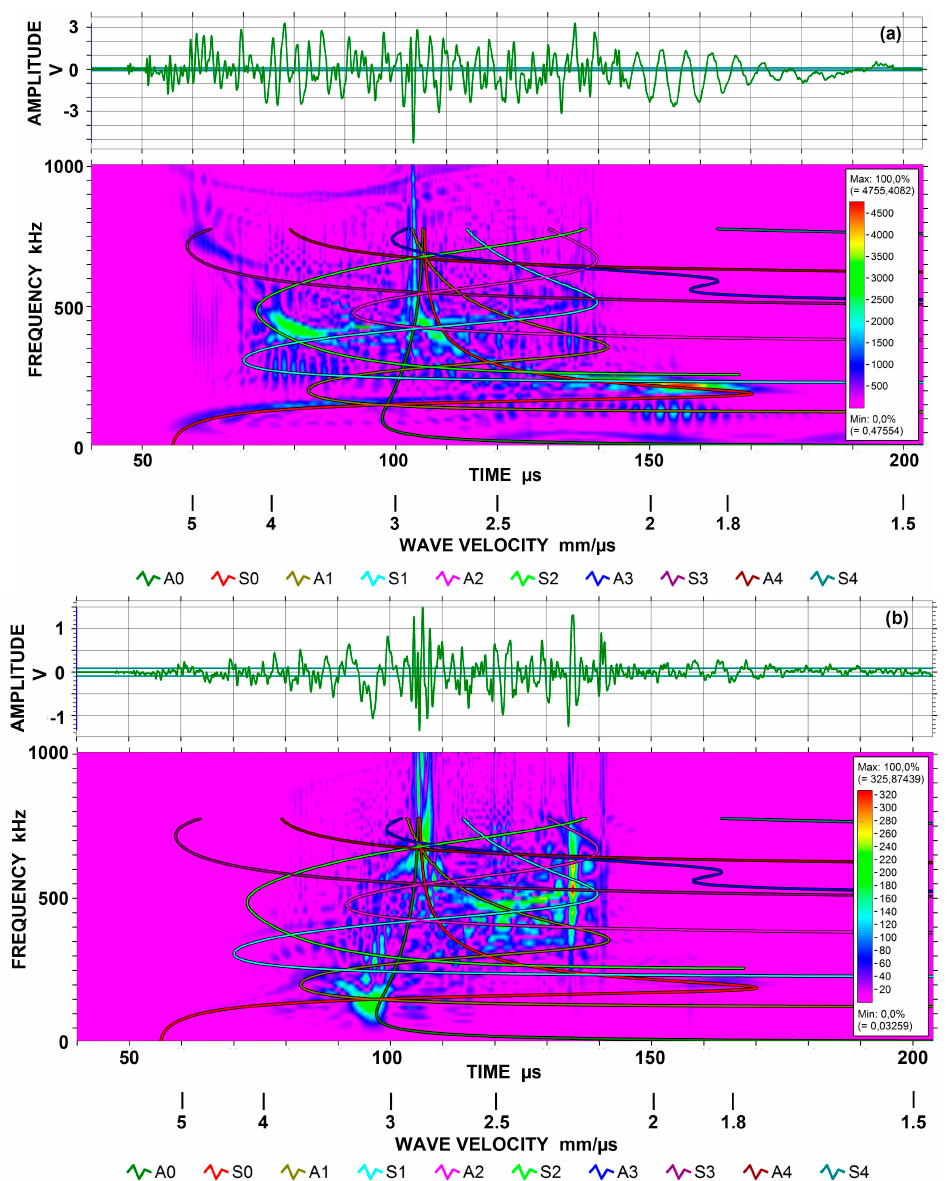
Figure 4. ( a ) Choi-Williams transform spectrogram for symmetrically excited Lamb waves on